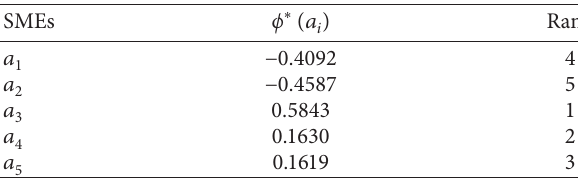
Table 14: Evaluation